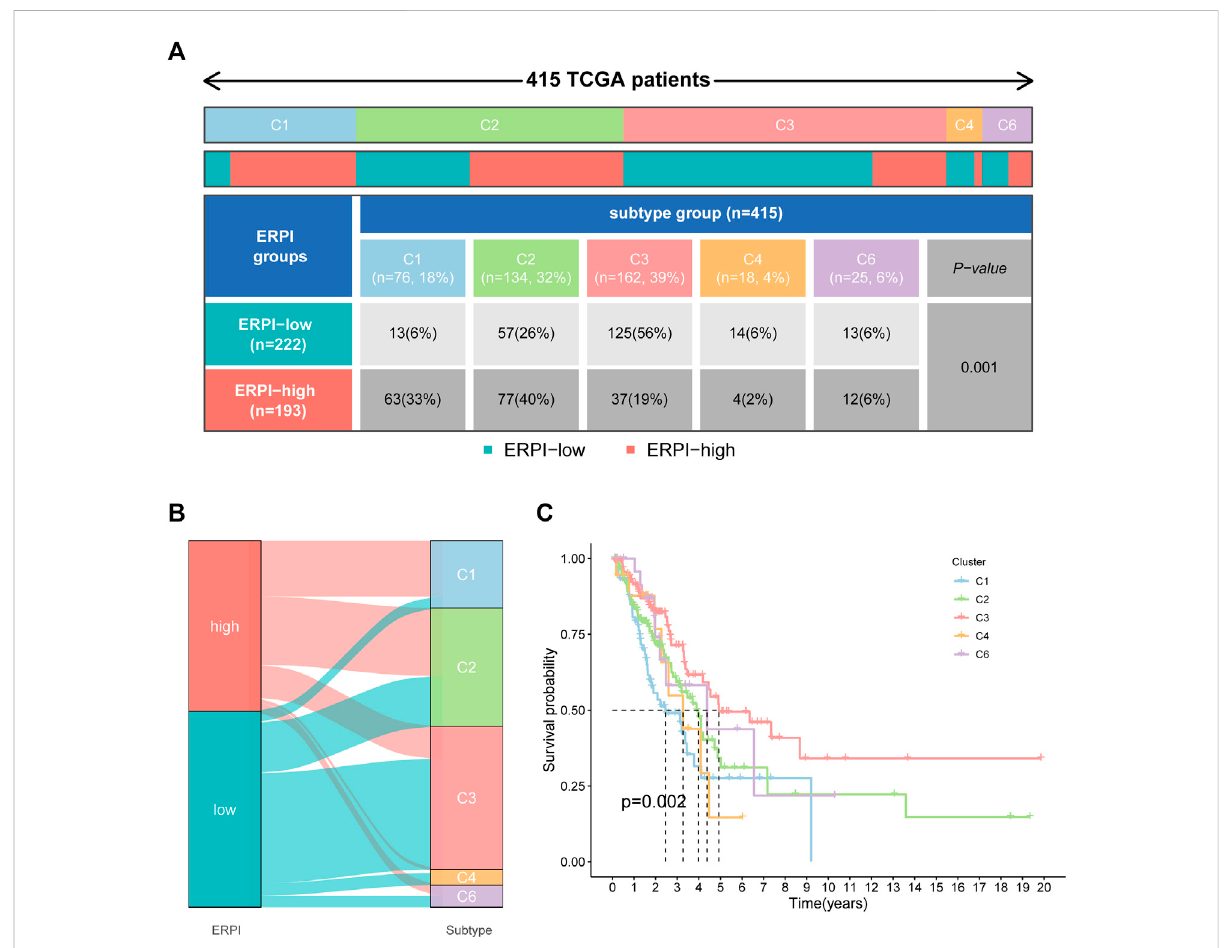
FIGURE 8 Correlation between ERPI and immune subgroups. (A) Percentage of immune subgroups in the high- and low-ERPI groups. (B) Distribution of immune subgroups in the high- and low-ERPI groups. (C) Survival curves of the immune